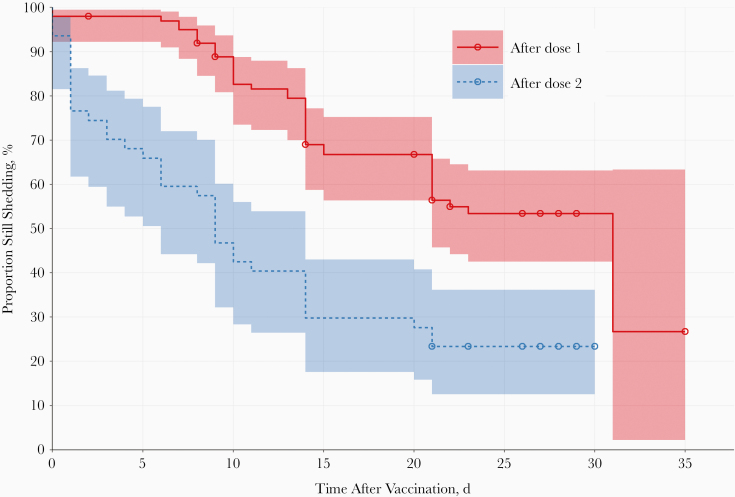
Proportions shedding virus in stool samples over the period after vaccination with monovalent type 2 oral poliovirus vaccine, shown as rate after each dose (with pointwise 95% confidence intervals as shaded areas). The day of cessation was defined as the last day when virus was detected in stool samples, with all following days being negative.